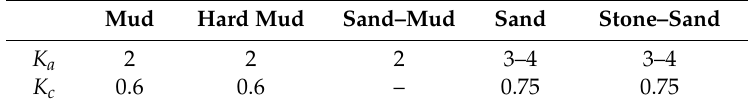
Table 1. Holding power coe ffi cient of anchor and anchor chain for di ff erent seabed conditions. Mud Hard Mud Sand–Mud Sand